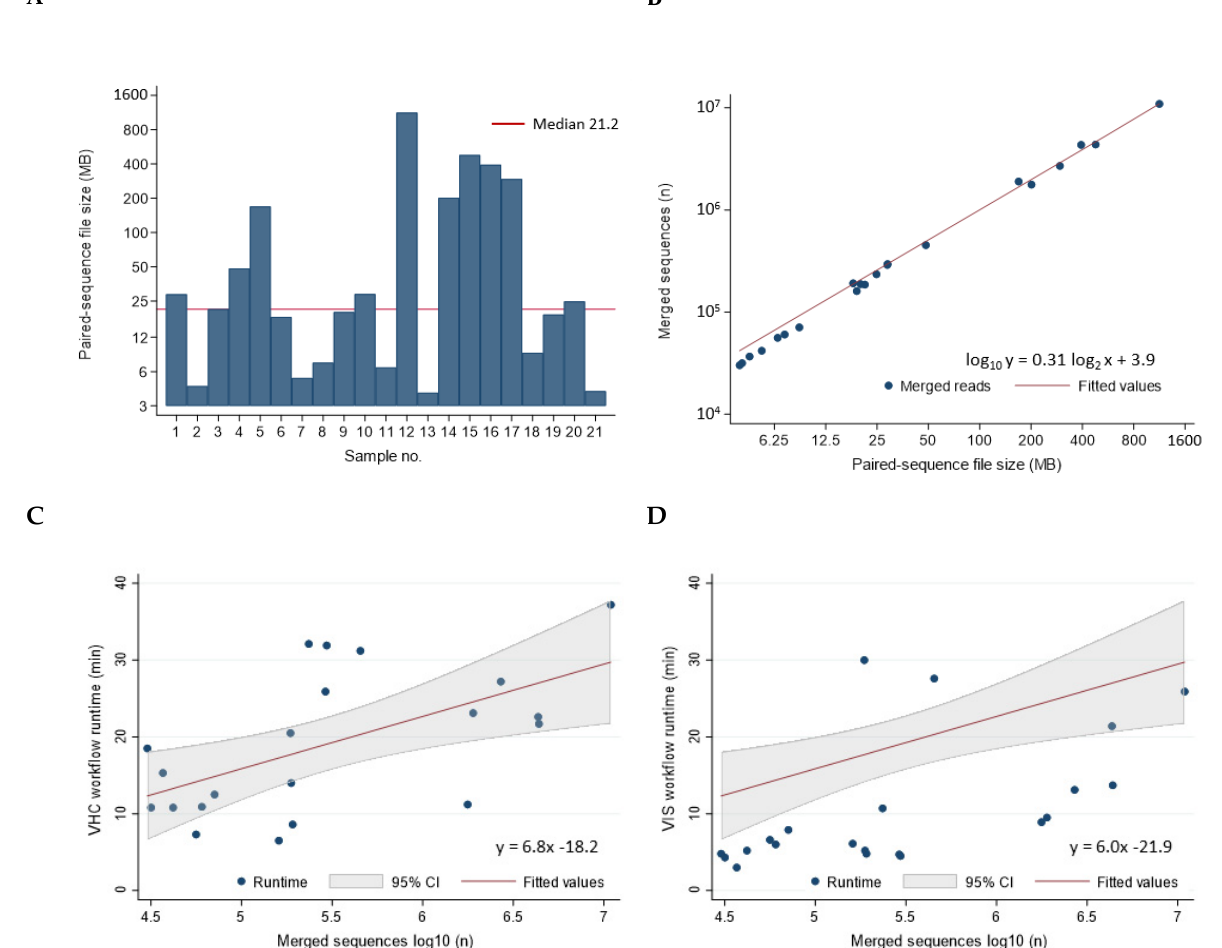
Figure 5. Correlation between NGS Reads and VHC/VIS Workflow Runtimes. ( A ) The sequencing file sizes of the 21 samples ranged broadly between 3.91 and 1130 MB with a median of 21.2 MB; ( B ) The file size correlated near-perfectly with the number of merged sequences after log 2 –log 10 transformation, respectively (R 2 = 0.998); ( C , D ) The number of merged reads (log 10 ) correlated positively with VHC and VIS workflow runtimes in a linear-log relationship. The correlation was modest for both VHC and VIS with R 2 = 0.335 and R 2 = 0.316, respectively. The regression equations may be utilized for estimation of workflow runtimes based on number of merged reads. Log transformation was performed to compress the wide range of X- or Y-values making it suitable for linear modeling.